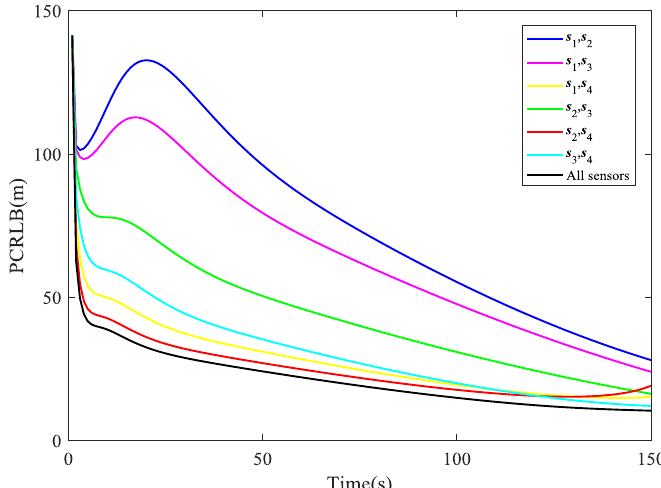
Figure 5. Comparison of RMSE (velocity estimation) when the initial process noise covariance is set to be smaller than the true value.